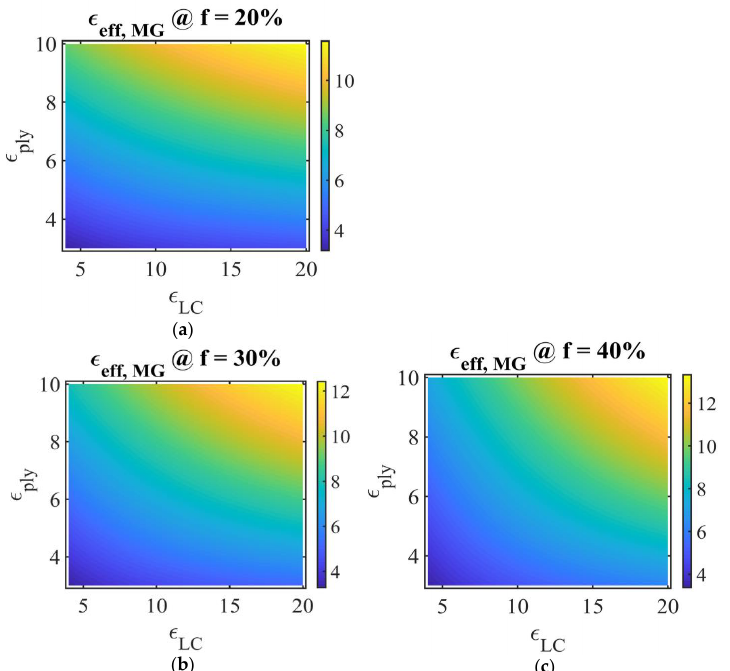
Figure 3. Representation of PDLC permittivity in the Maxwell Garnett model, for different LC fractions: ( a ) f LC,a = 0.2; ( b ) f LC,b = 0.3; ( c ) f LC,c = 0.4. Ox: LC permittivity ε LC , Oy: polymer permittivity ε ply ; vertical color bar: PDLC film effective permittivity using the Maxwell Garnet model, symbol @ stands for “at”.